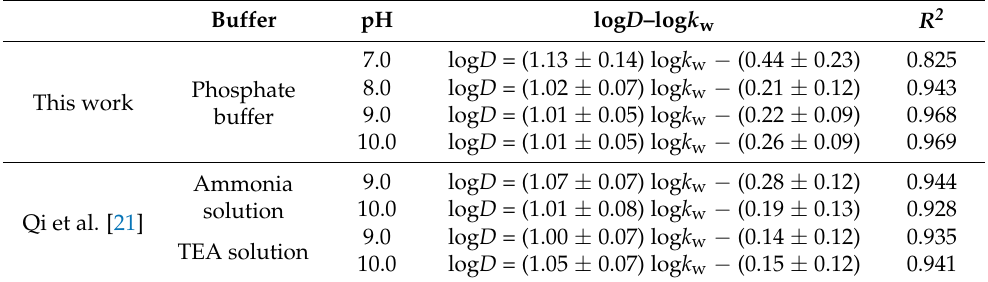
Table 2. log D –log k w relationships derived from model compounds 1 – 14 at different mobile phases. Buffer pH log D –log k